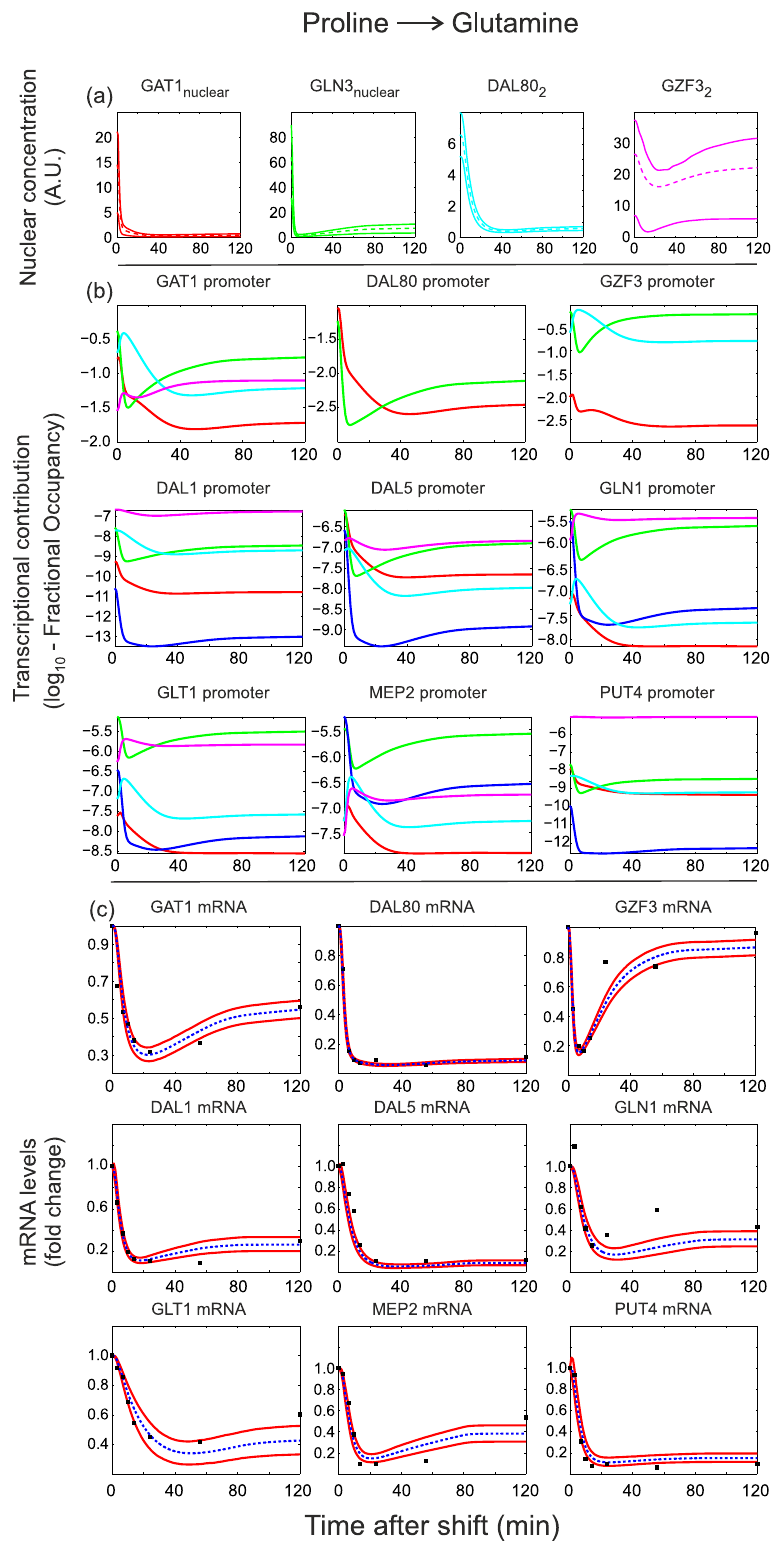
Fig 6. Model M 135 predictions and fi ts to target mRNA data (fold changes) for the Pro ! Gln shift. (a) Abundance of GATA factor active forms (nuclear Gln3 and Gat1, and Dal80 and Gzf3 homodimers). In